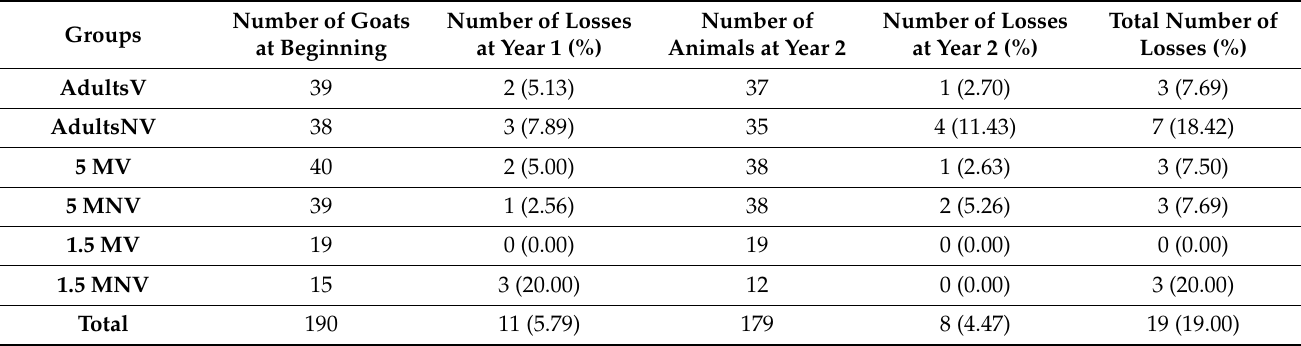
Table 1. Losses of goats vaccinated with Gudair ® (V) or not vaccinated (NV) with percentages and distribution according to each experimental group throughout the period studied (1st and 2nd year, and total). AdultsV: vaccinated at more than 1.5 years; AdultsNV: not vaccinated at more than 1.5 years; 5 MV: vaccinated at 5 months; 5 MNV: not vaccinated at 5 months; 1.5 MV: vaccinated